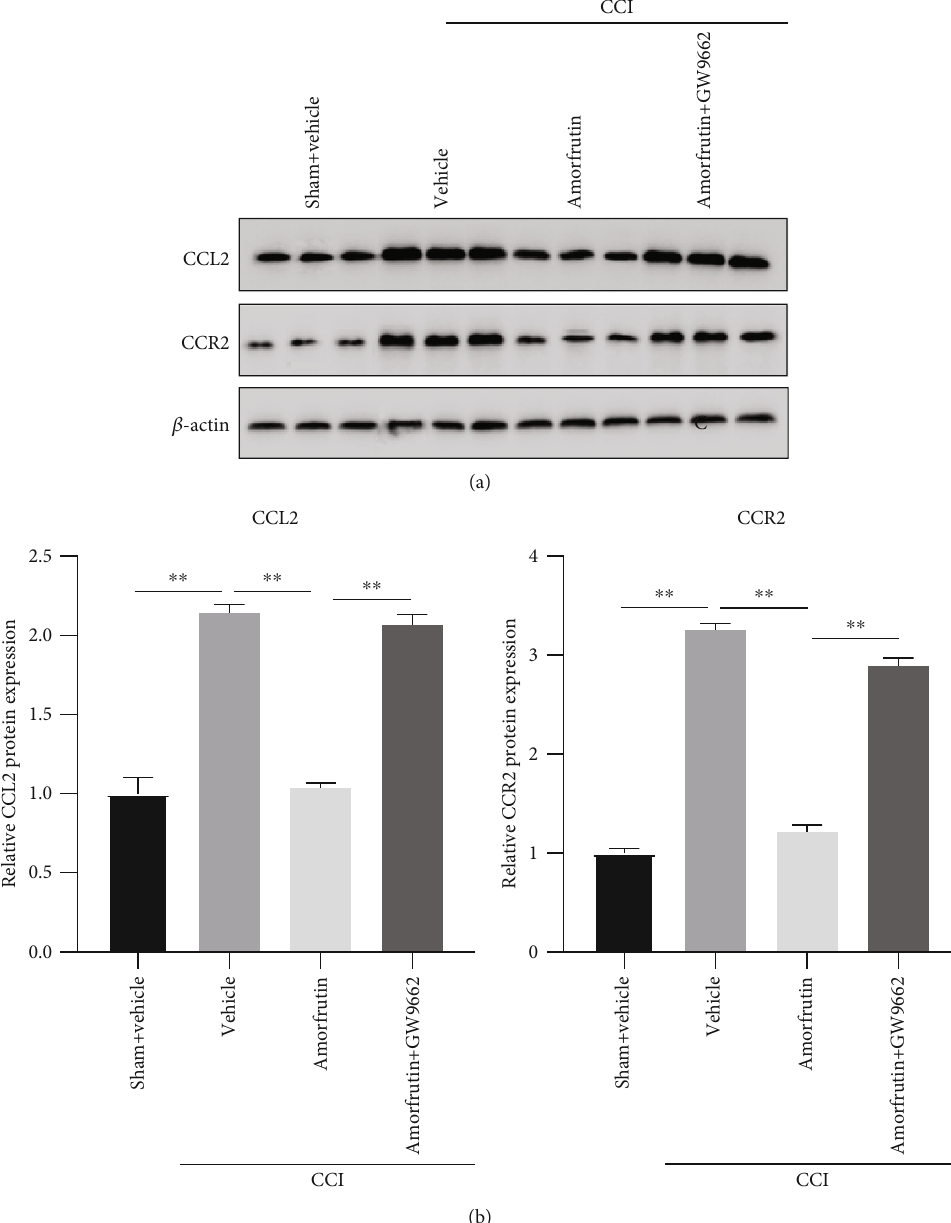
Figure 4: PPAR γ activation suppressed chemokines CCL2/CCR2 expression in CCI rats. The expression of CCL2/CCR2 protein was examined by western blot. Amorfrutins decreased the CCL2/CCR2 expression through the PPAR γ